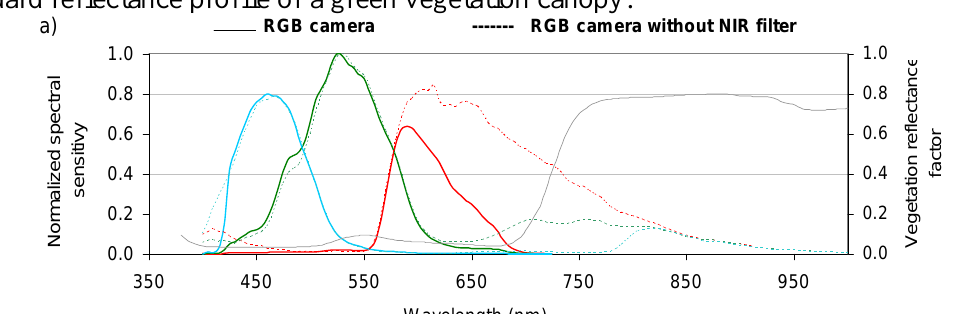
Figure 2. Normalized spectral sensitivity of CANON EOS 400D cameras: (a) the original (RGB) and modified (without NIR filter), (b) the original (RGB) and modified (RDG and NIR). The colours of the lines correspond to the camera channels. The grey line is a standard reflectance profile of a green vegetation